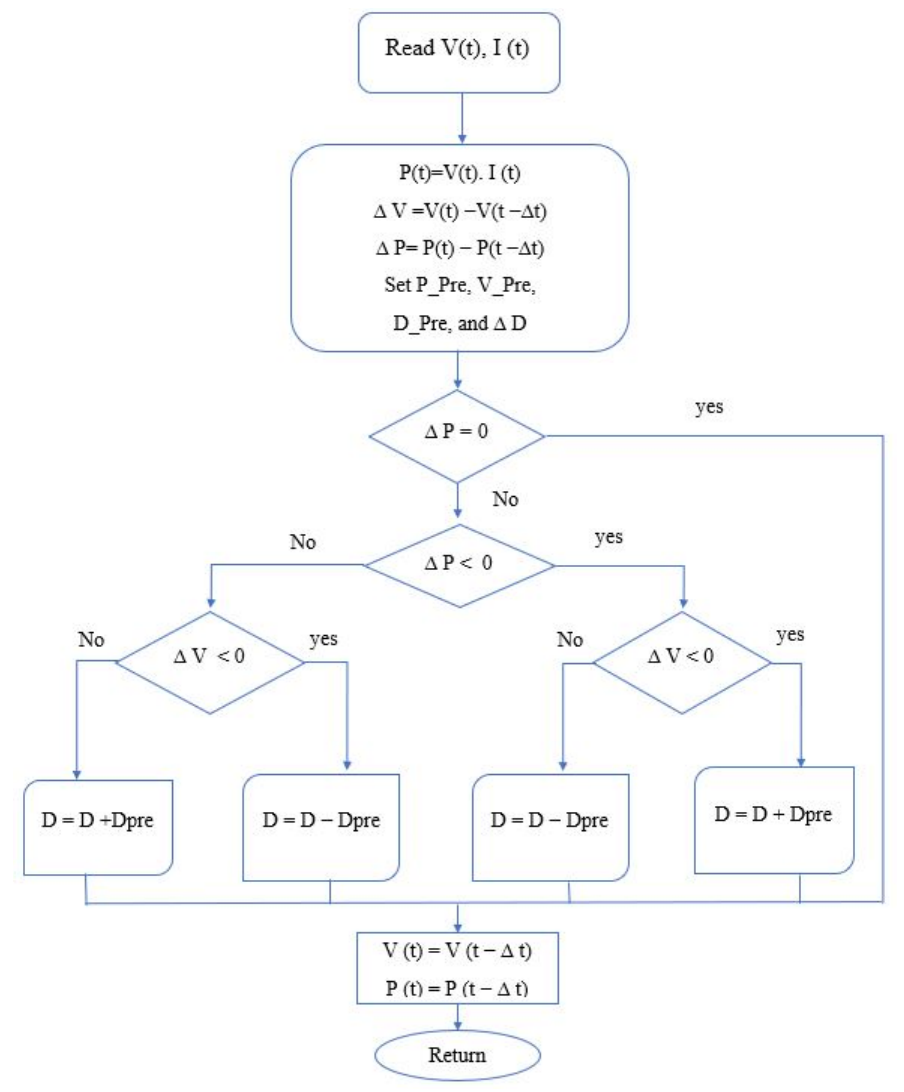
Figure 4. Flowchart of the Perturb and Observe (P&O) algorithm.